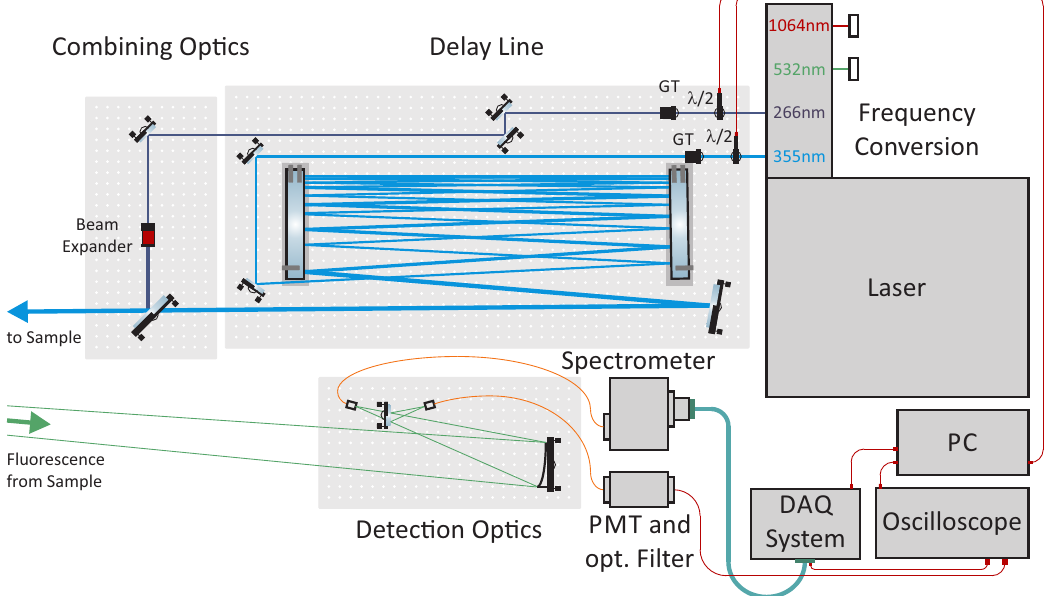
Figure 1. Scheme for standoff laser-induced fluorescence (LIF) detection setup including dual-wavelength excitation and the acquisition of spectral and time-resolved fluorescence (GT: Glan–Taylor prism, PMT: photomuliplier